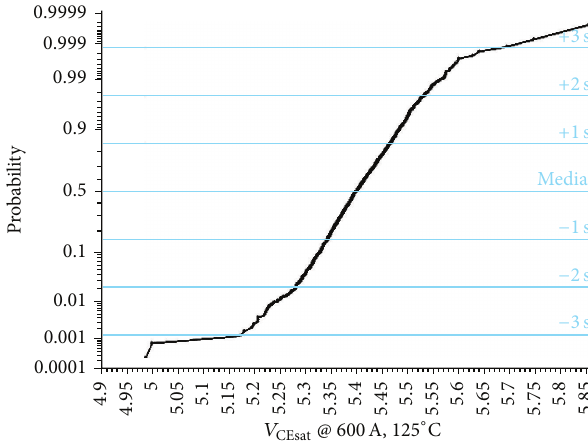
Figure 6: On-state process (6500V/600 A)